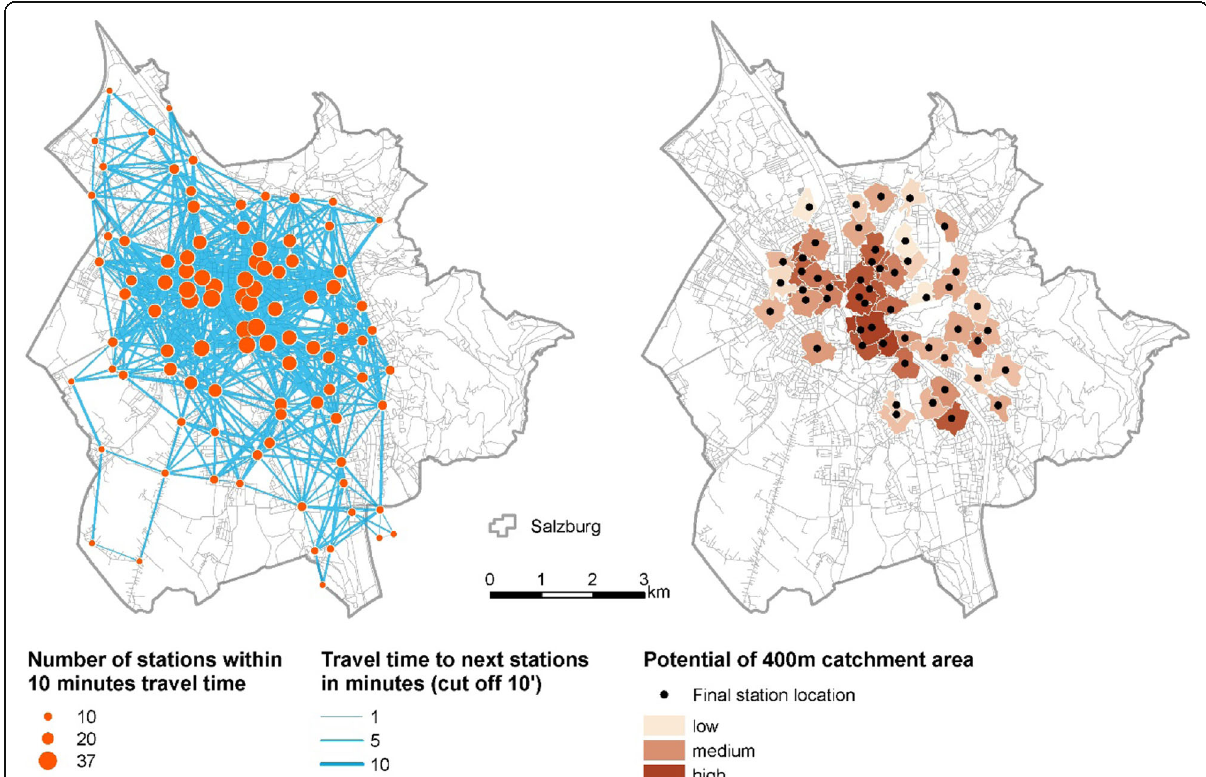
Fig. 9 Analysis of network connectivity of the planned stations (left) and potential of the planned stations